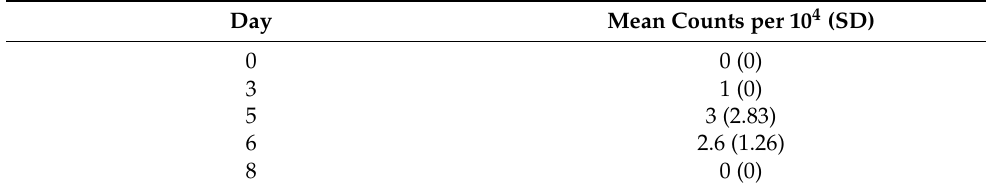
Table 1. Mean transcript counts (with standard deviation) for IFN- β from a longitudinal study of EBOV infection in rhesus macaques